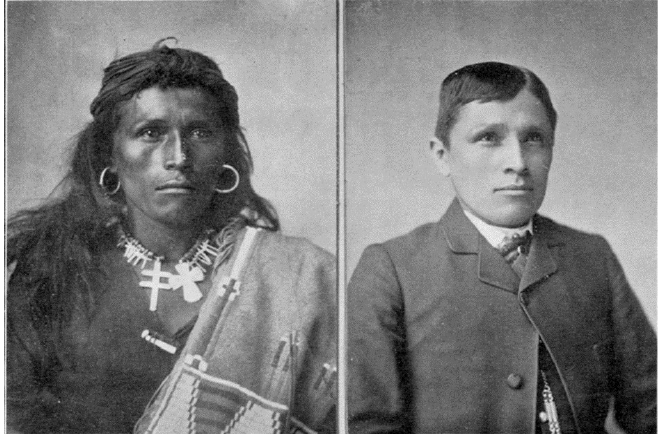
Figure 1. Tom Torlino—Navajo, “As he entered the school in 1882” and “As he appeared three years later” from Souvenir of the Carlisle Indian School , 1902. Courtesy of the Carlisle Indian School Digital Resource Center.